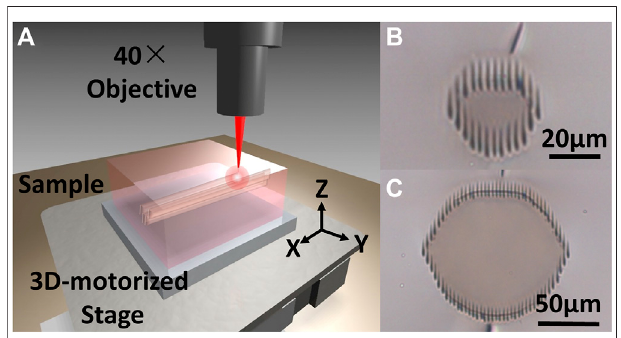
FIGURE 1 | (A) Schematic of the direct femtosecond laser writing process. (B,C) Opticalmicroscopeimagesofthecrosssectionsofdepressed cladding waveguides with diameters of 30 and 100 μ m,